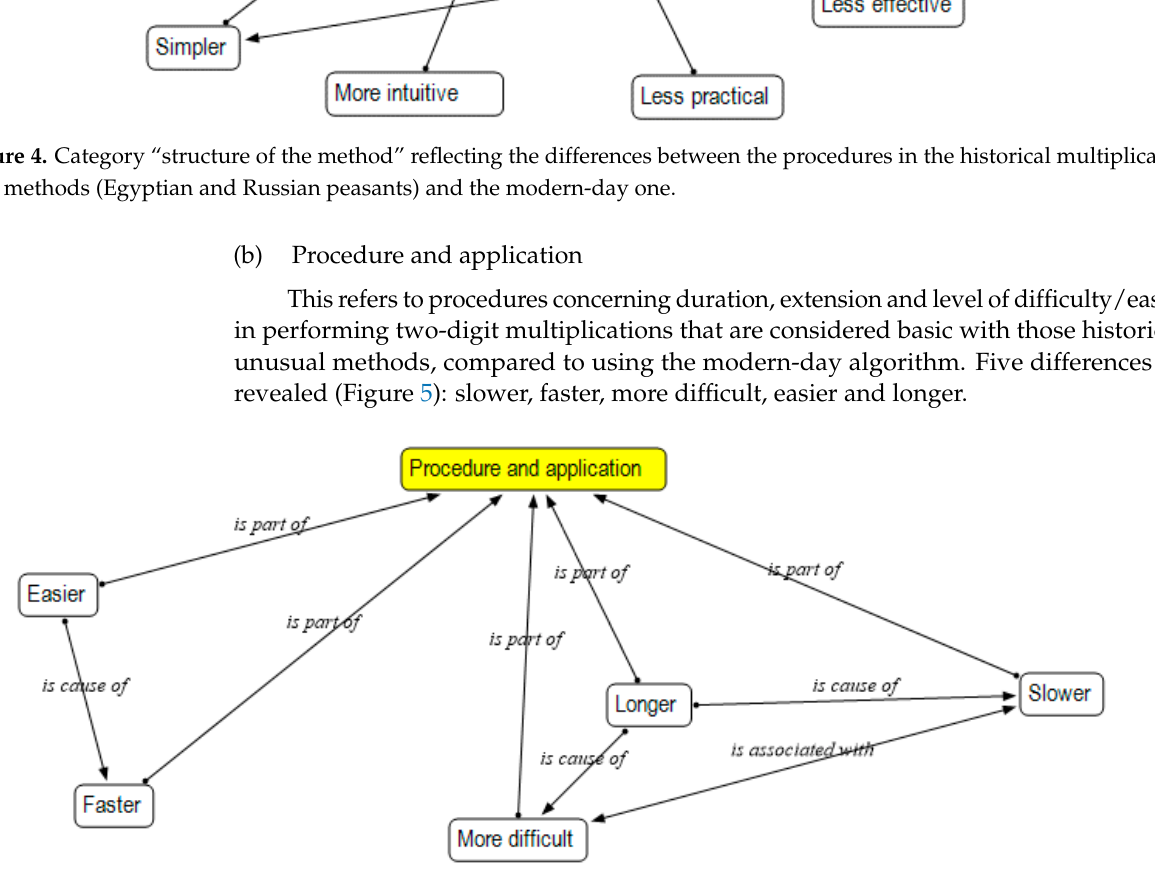
Figure 5. Category of “procedure and application” regarding